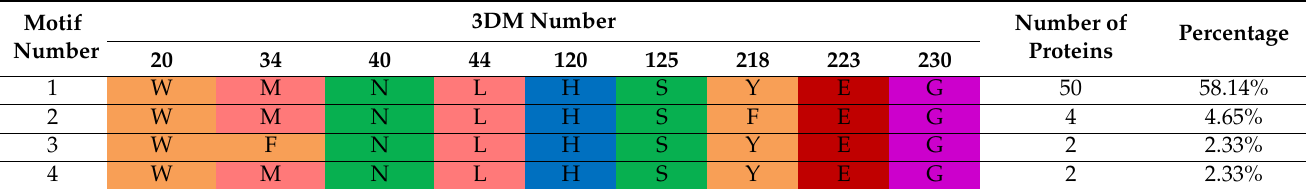
Table 2. Motif overview of residues for short UPO candidates with the catalytic residues PCP, EHD, G and E. Amino acids are coloured in accordance with their physicochemical properties following the Zappo colour